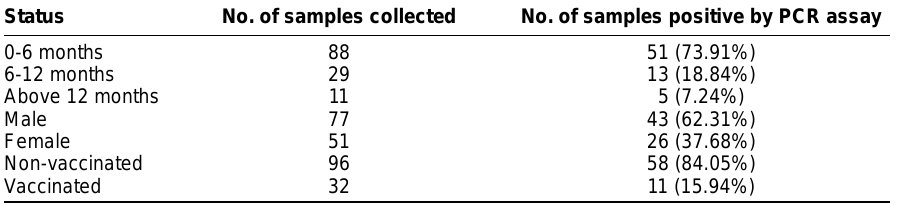
Table-2. Details of occurrence of CPV based on age, sex and vaccination status